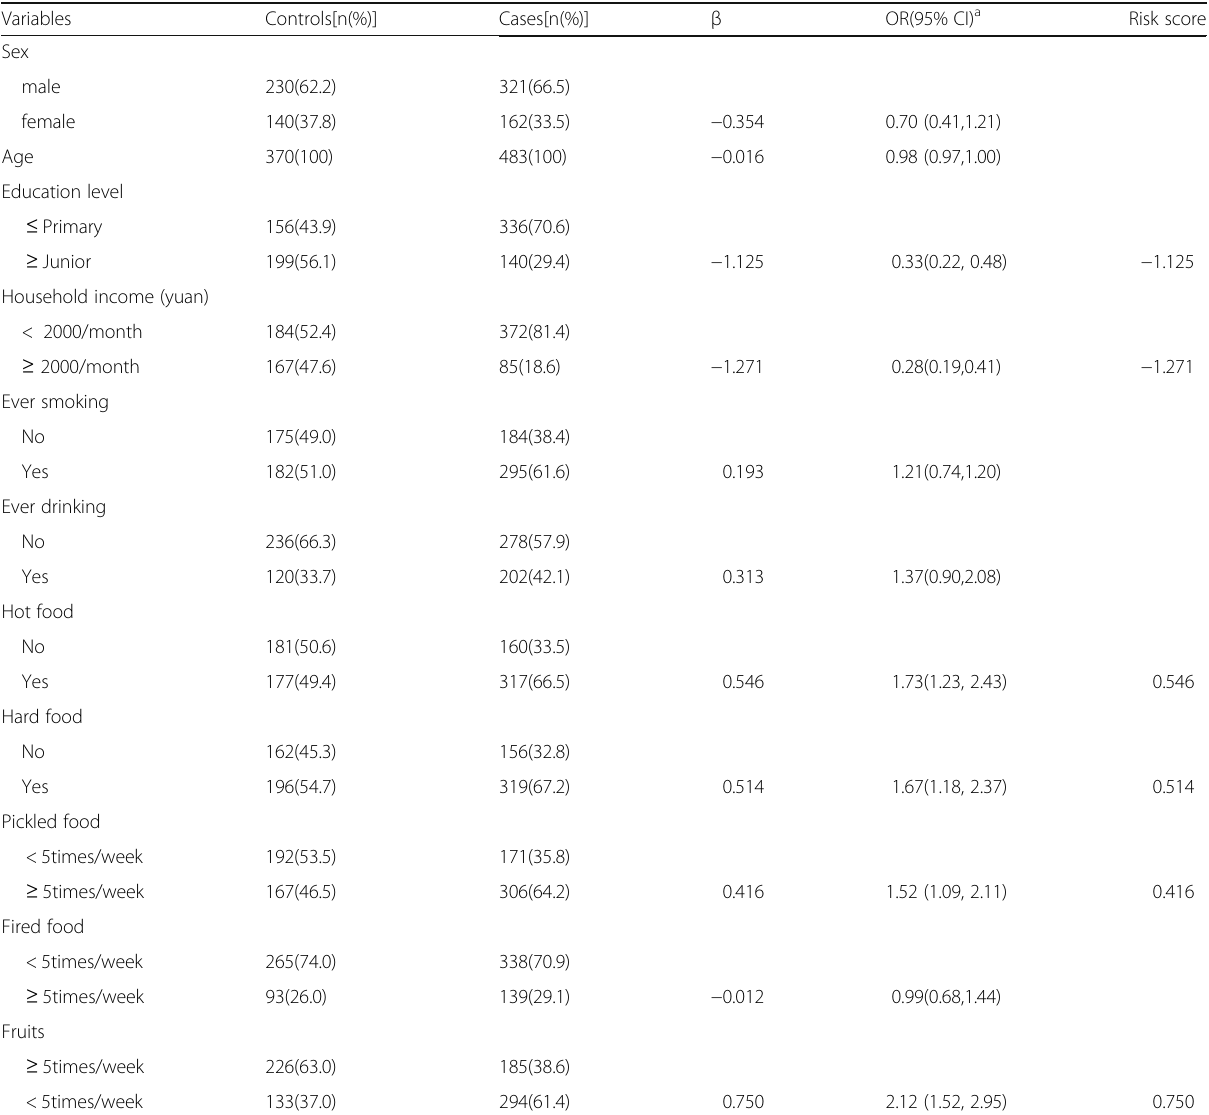
Table 3 The risk score coefficients for